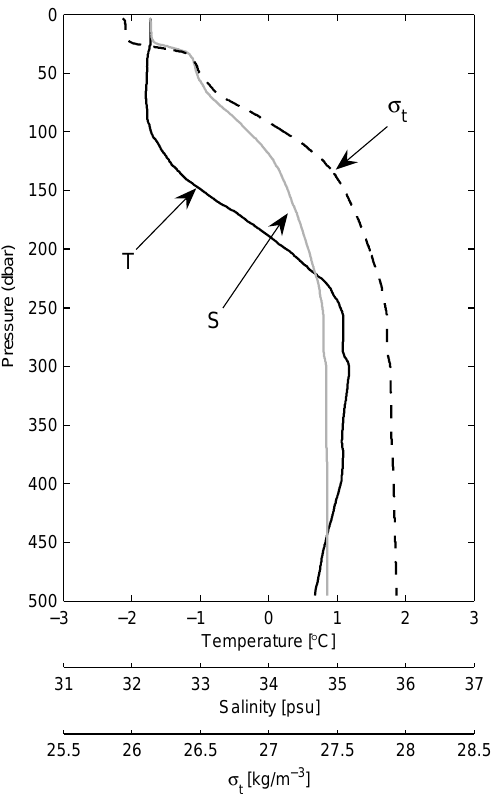
Fig. 4. Temperature, salinity and potential density averaged over the first 24h (7 profiles) of the ASCOS experiment.